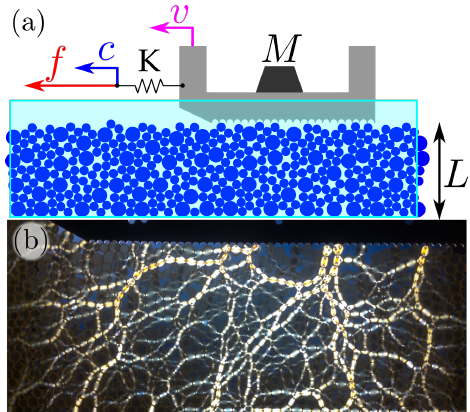
Figure 1: (a) Sketch of the experiment. A slider sits on top of a 2D granular system with photoelastic disks, and is connected to a stage by a spring of constant k , pulled by a constant speed c . A force gouge measures the force f ; the granular medium is imaged with fast cameras. (b) Photoelastic response during loading [10]. Reprinted with permission from